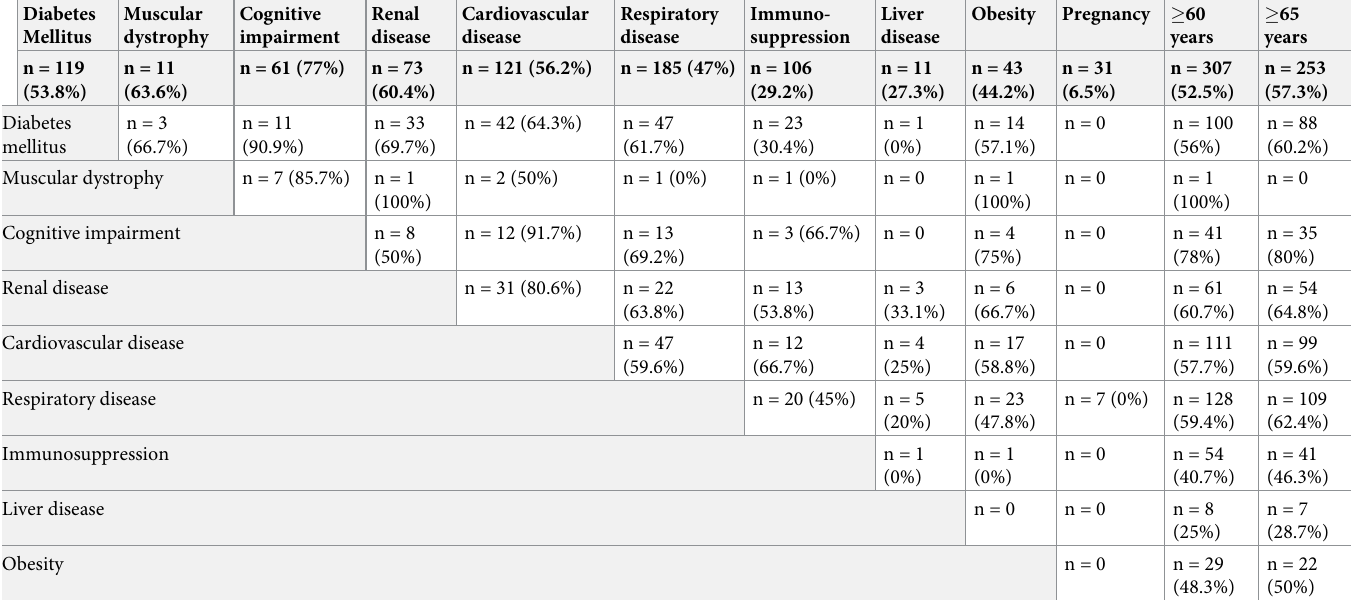
Table 2. Percentage of influenza-vaccinated patients by underlying conditions in laboratory-confirmed influenza cases receiving care at the GTiPUH in Badalona (Spain) during the 2018–2019 influenza epidemic